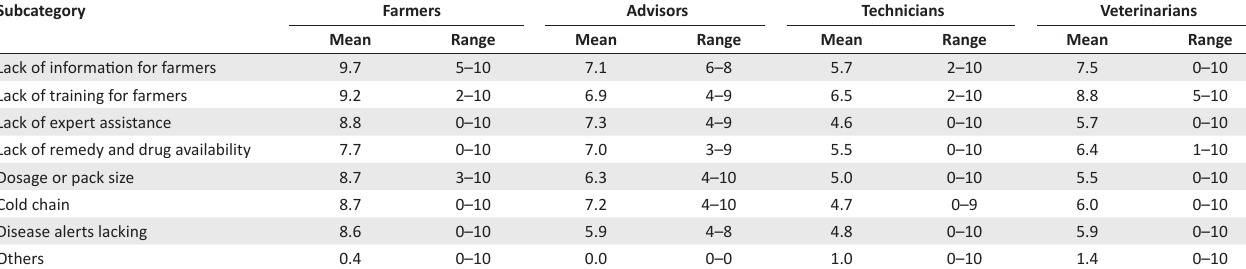
Table 11 reflects how respondents from the farmer and technical groups rated a list of training pamphlets. Farmer